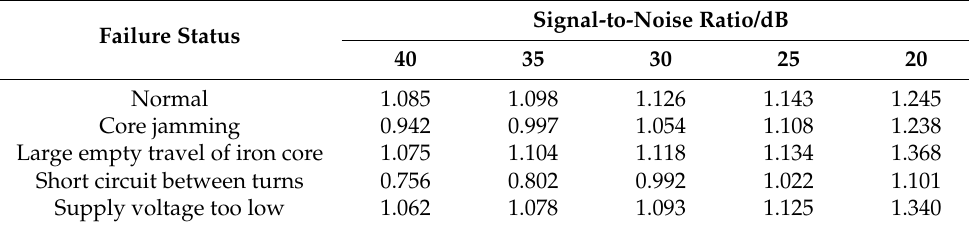
Table 3. Average error of phase trajectory feature extraction under different levels of noise.